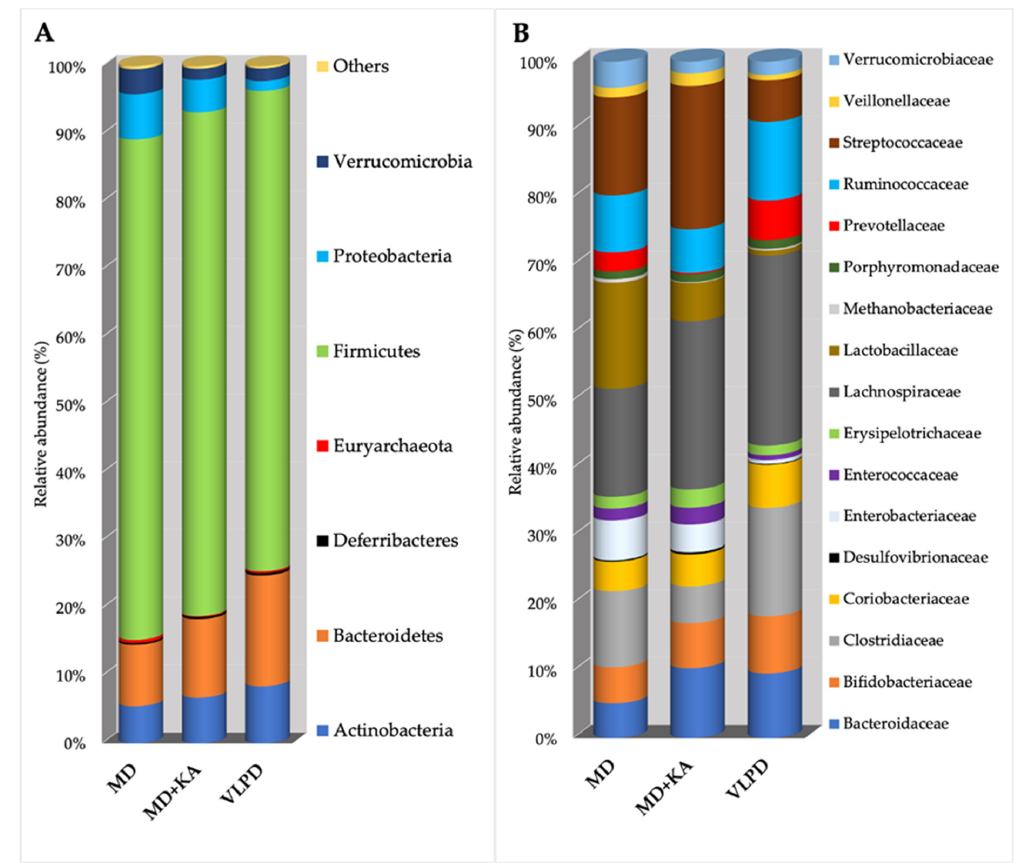
Figure 1. Fecal microbiota composition in chronic kidney disease (CKD) patients associated with different dietary regimens. Three different dietary regimens were evaluated: the Mediterranean diet (MD), Mediterranean diet supplemented with ketoanalogs (MD + KA), and the very-low-protein diet supplemented with ketoanalogs (VLPD). The panel on the left ( A ) shows the relative abundance (as percentual average) of gut bacterial phyla found in CKD patients after each dietary regimen. Phyla with a relative abundance <0.1% in all samples were grouped together and named “Others”. The right panel ( B ) shows the relative abundance (as percentual average) of gut bacterial families (>1% at least in one sample) found in the feces of CKD patients after each dietary regimen.